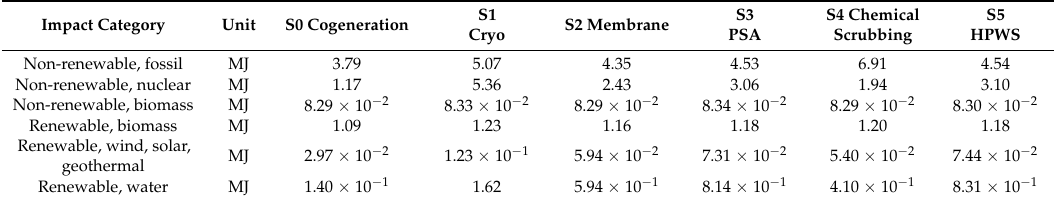
Table 3. Cumulative Energy Demand (CED) characterized impacts calculated for different conversion routes of biogas, with reference to a functional unit of 1 m 3 of used